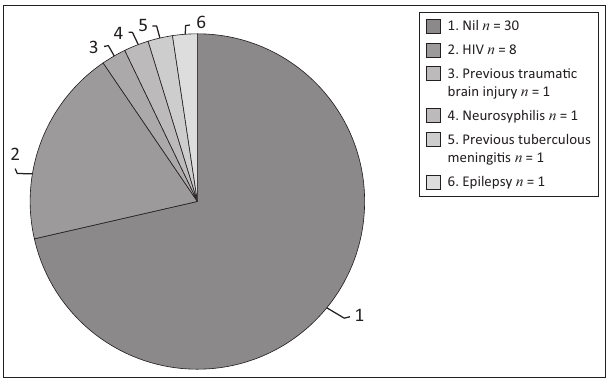
FIGURE 2: Distribution of medical comorbidities ( n =